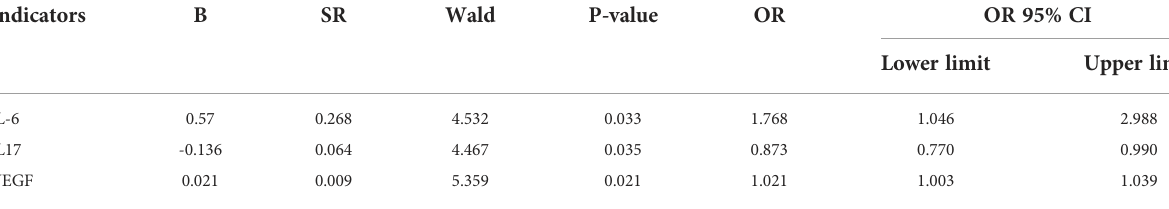
TABLE 2 Comparison of independent risk factors for breast